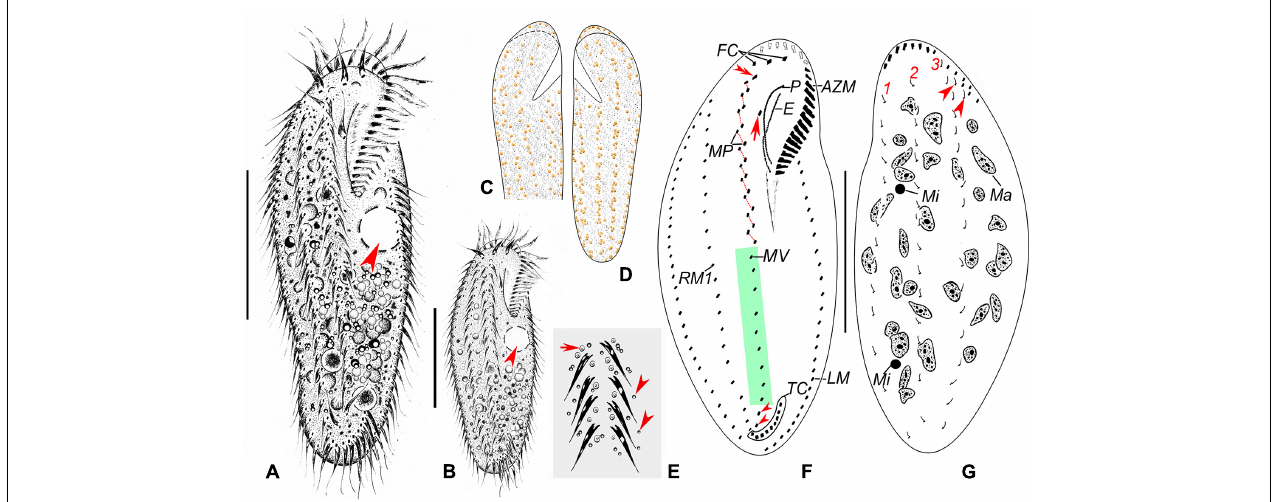
FIGURE 2 | Morphology and infraciliature of Heterobakuella bergeri gen. nov., sp. nov. from life (A–E) and after protargol impregnation (F,G) . (A,B) Ventral views of a typical individual (A) and a different cell (B) , showing the body shape. Arrows depict the contractile vacuole. (C–E) Arrangement of cortical granules on ventral (C,E) and dorsal (D) sides, arrow and arrowheads in (E) indicate details of cortical granules and globules, respectively. (F,G) Ventral (F) and dorsal (G) views of the holotype specimen, showing infraciliature and nuclear apparatus. In (F) , arrow shows buccal cirrus, arrowheads mark pretransverse cirri, and double-arrowhead indicates parabuccal cirrus. Arrowheads in (G) indicate two additional dorsal bristles. AZM, adoral zone of membranelles; E, endoral membrane; FC, frontal cirri; LM, left marginal cirral row; Ma, macronuclear nodules; Mi, micronuclei; MP, midventral cirral pairs; MV, midventral cirral row; P, paroral membrane; RM1, right marginal cirral row 1; TC, transverse cirri; 1–3, dorsal kineties 1–3. Scale bars = 50 µ